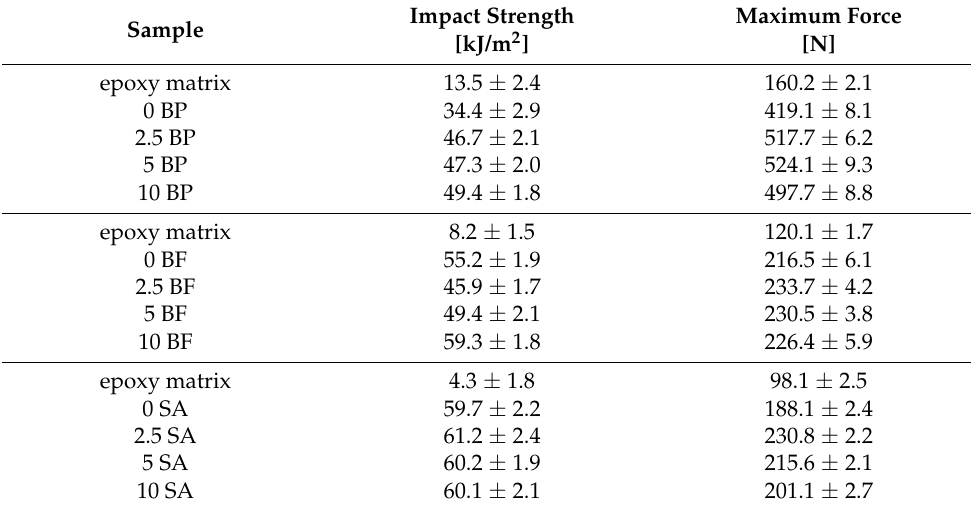
Table 2. Impact values of the tested composites and epoxy